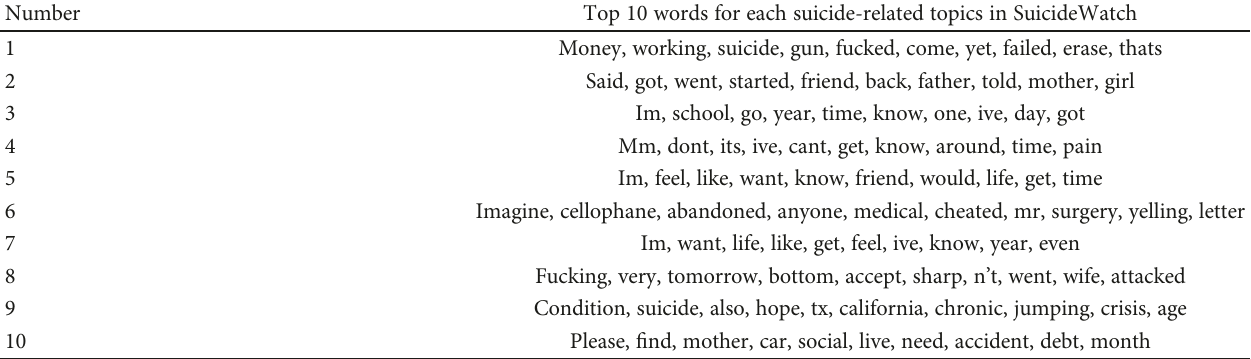
Table 4: Topic words extracted from posts containing suicidal